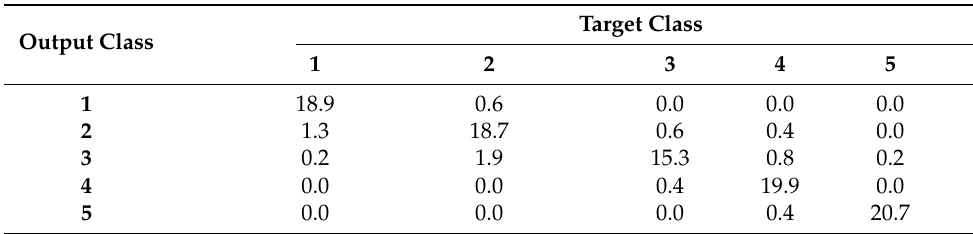
Figure 4. ( a ) The performances of the model training with epochs increasing. ( b ) The enlarged curves from epoch 570 to 610, where the best validation performance is at epoch 604. Table 1. The confusion matrix of the classification results (unit: %). Test Confusion Matrix, CCR =